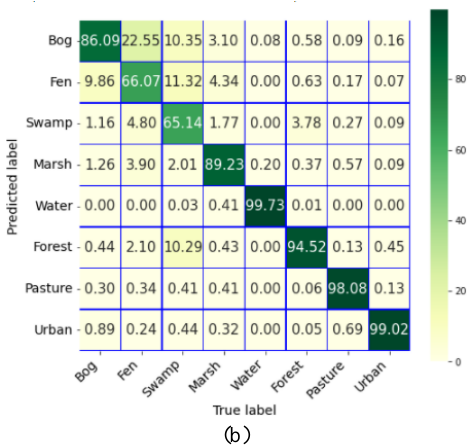
Figure 4 . (a) the classification map and (b) confusion matrix for the VC approach.